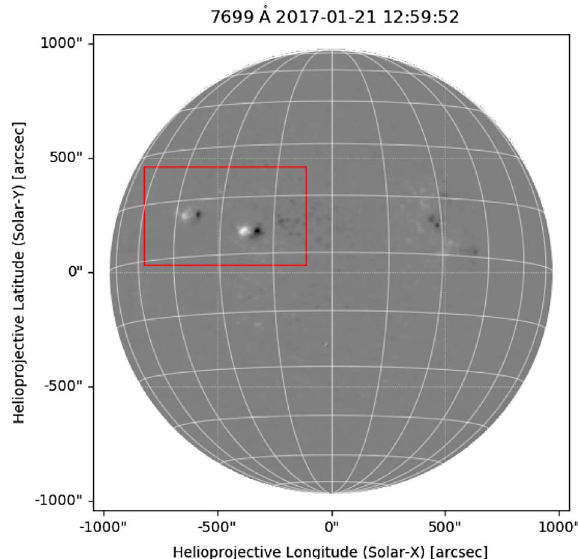
Fig. 11. LoS magnetogram acquired by the MOTH 769.9 nm (K D 1 ) channel on January 21, 2017 during the Antarctica summer campaign 2016/17. The red box indicates the area including the fl aring AR12628 (on the left ) and the non- fl aring AR12627 (on the right ) regions considered for the